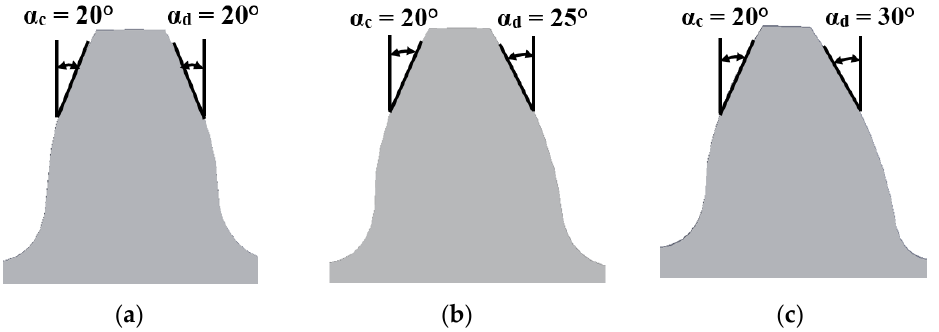
Figure 1. The e ff ect of DSPA on the spur gears’ geometric characteristics: ( a ) 20°/20°; ( b ) 20°/25°; ( c ) Figure 1. The effect of DSPA on the spur gears’ geometric characteristics: ( a ) 20 ◦ /20 ◦ ; ( b ) 20 ◦ /25 ◦ ; 20°/30° tooth pro fi les. ( c ) 20 ◦ /30 ◦ tooth profiles.